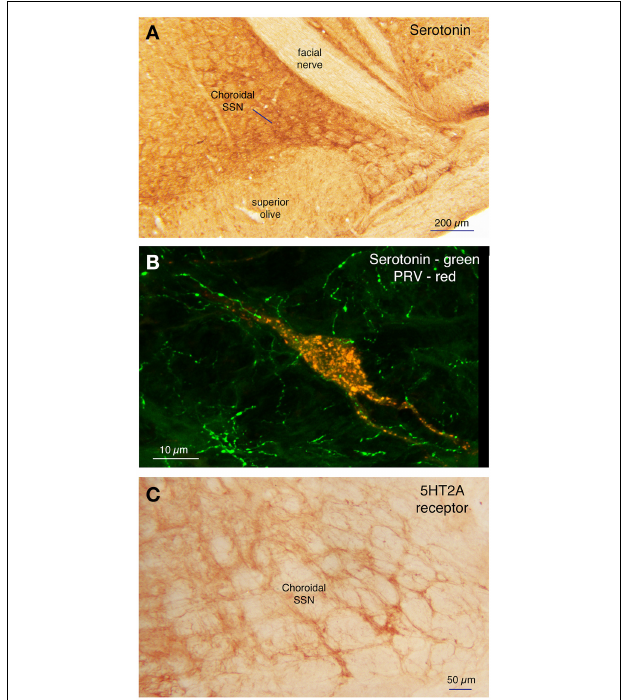
FIGURE 10 | Choroidal SSN is enriched in serotonergic terminals (A), and PRV + SSN choroidal neurons (red) were seen to be contacted by serotonergic terminals (green) (B). Moreover, choroidal SSN is enriched in 5HT2A serotonin receptors (C) .